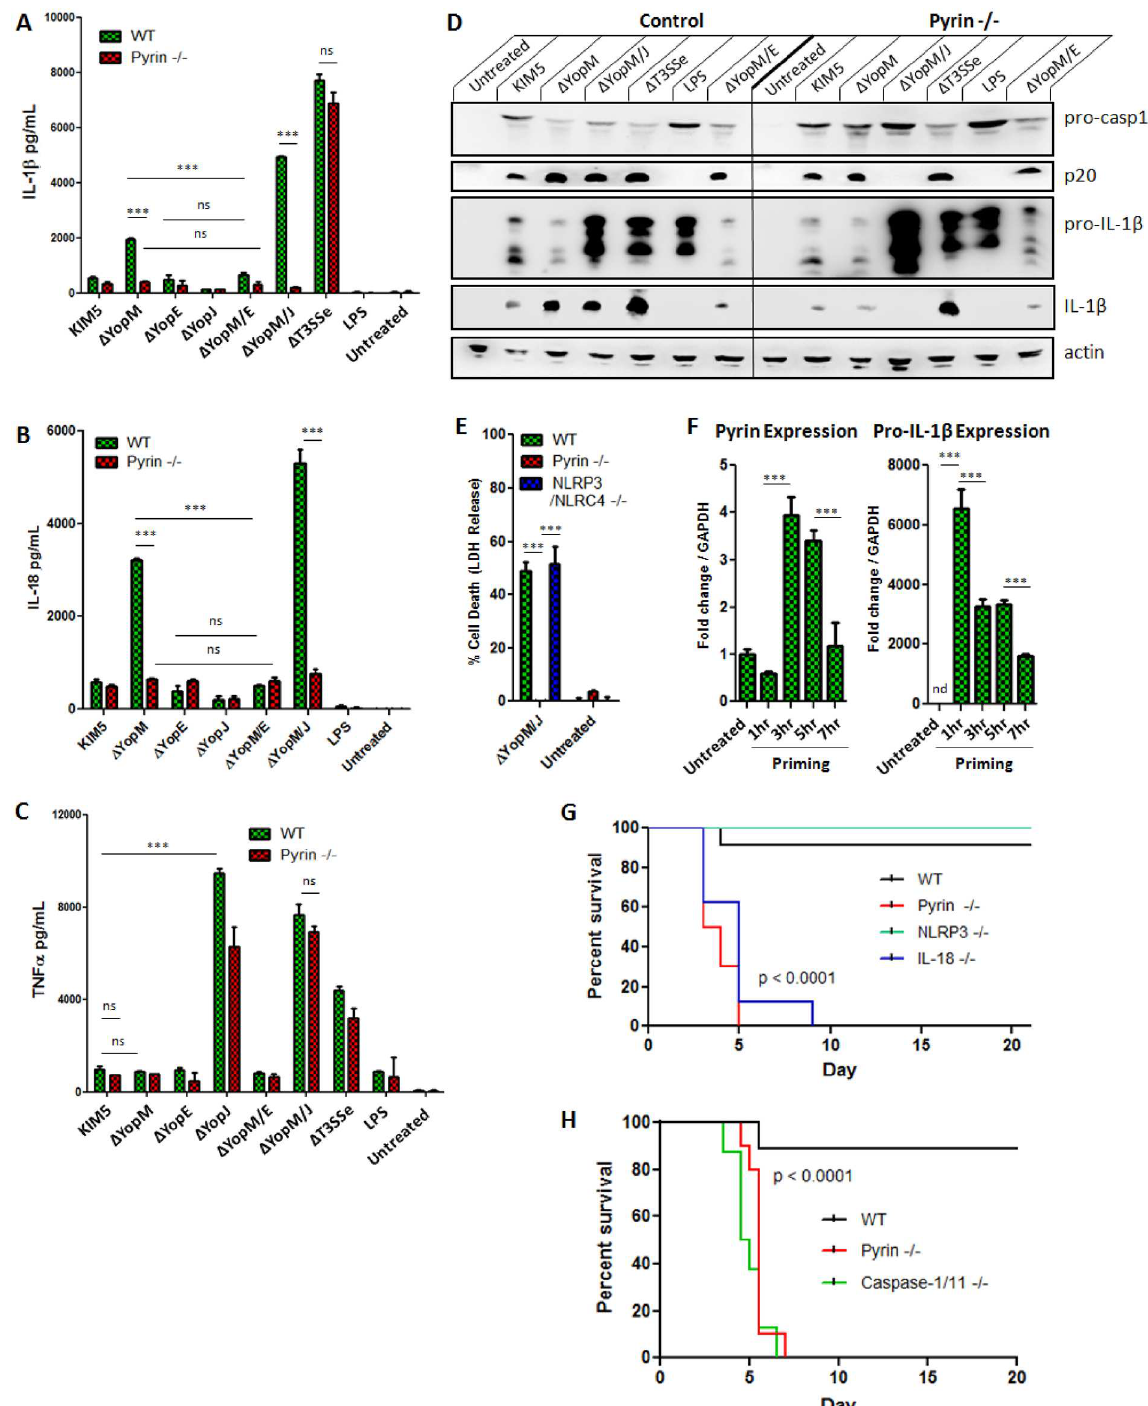
Fig 2. LPS-primed BMDMs were infected with indicated Y . pestis strains for 6 hours; A) IL-1 β , B) IL-18, and C) TNF α were measured in supernatants by ELISA 6 hrs p.i. (MOI 10); D) Total protein from LPS-primed BMDMs infected with indicatedstrains (combined cell lysate and supernatant) was separatedby SDS-PAGE and analyzedby Western Blot for IL-1 β and caspase-1.E) Cell death was assayed by LDH release in LPS-primed BMDMs infected with indicatedstrains at 6 hrs p.i. (MOI 10). F) Expression of Pyrin and Pro- IL-1 β mRNA was measuredby RT-PCR at 1, 3, 5, or 7 hours after additionof 100ng/mLLPS to WT BMDMs. G) WT C57Bl/6(n = 12), Pyrin KO (n = 10), NLRP3 KO (n = 7) or IL-18 KO (n = 8) or H) WT (n = 9), Pyrin KO (n = 10) or caspase-1/11 KO (n = 8) mice